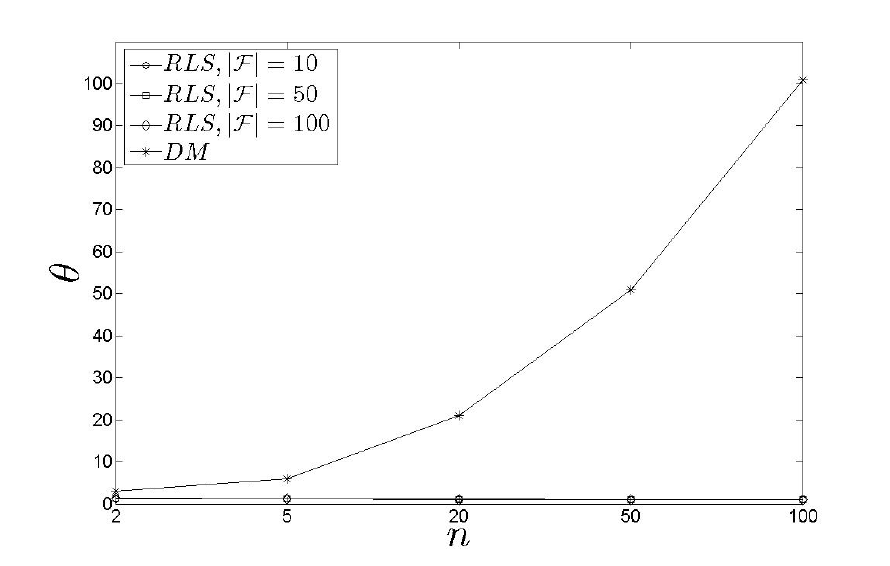
Figure 15. θ results for the RLS .